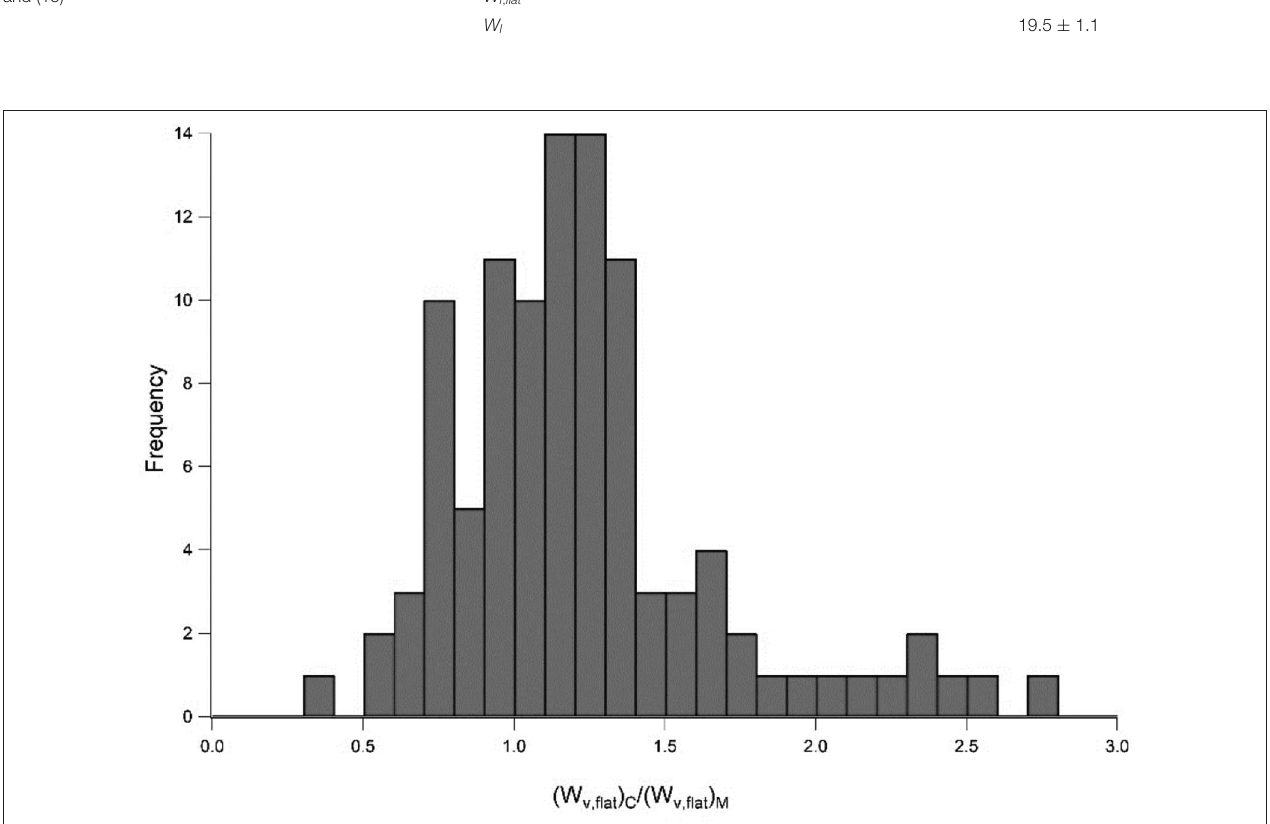
FIGURE 8 | Histogram of the ratios of the calculated wear volumes of the planes ( W v , flat ) C to the measured wear volumes of the planes ( W v , flat ) M .